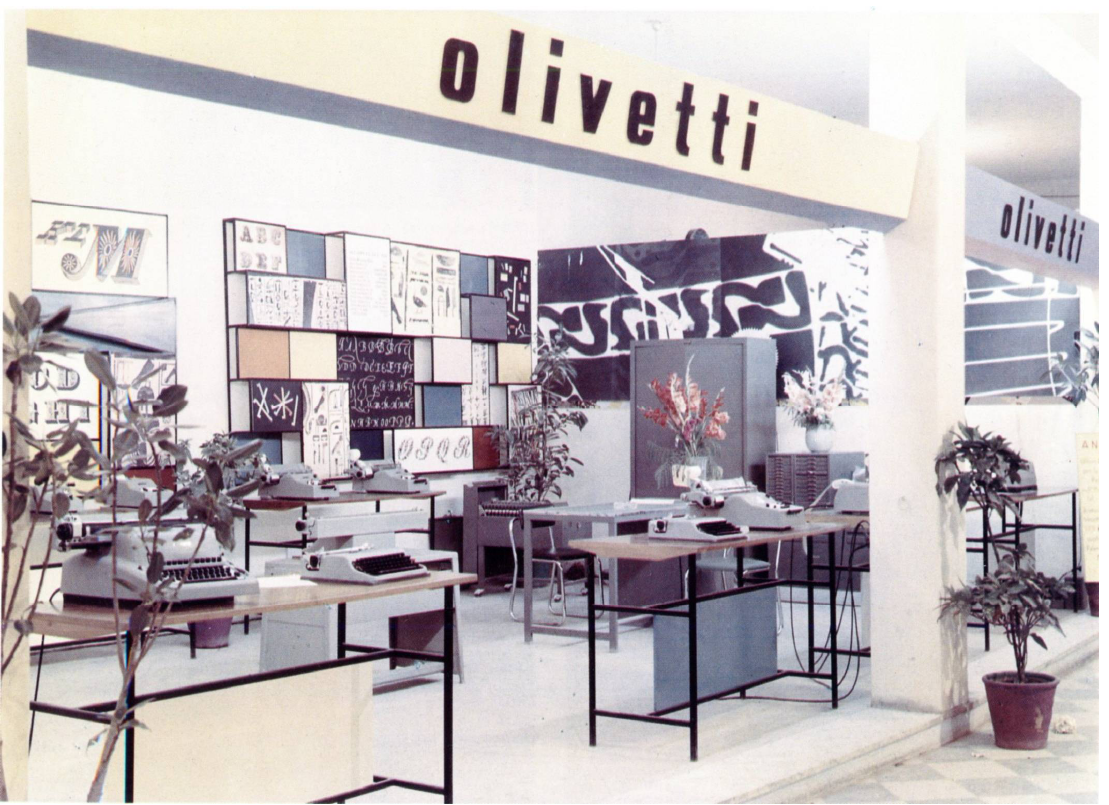
Figure 11. Olivetti stand,